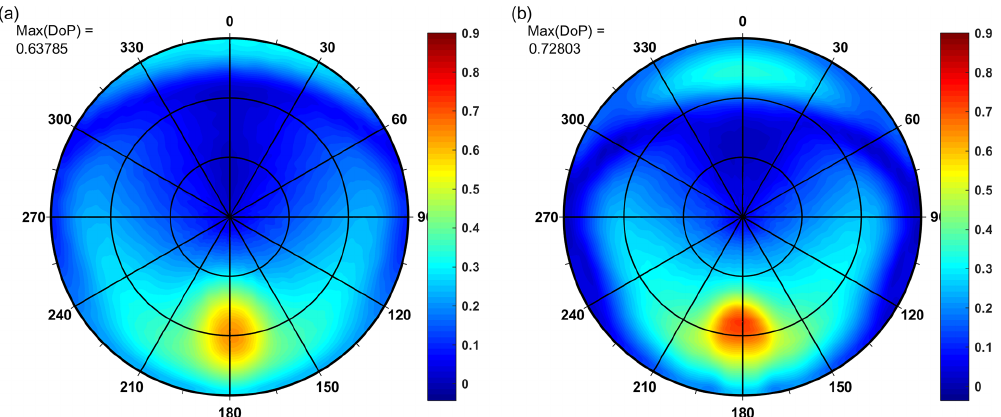
Figure 3. Simulation results of above-water upwelling radiance for average IOPs of gulf waters of the southern Baltic, wavelength 555nm, for speed of wind of 5ms − 1 : (a) DoP in the summer season, SZA 45 ◦ , (b) DoP in the winter season, SZA 75 ◦ . Concentric circles inside mean zenith angles of 30 and 60 ◦ ,